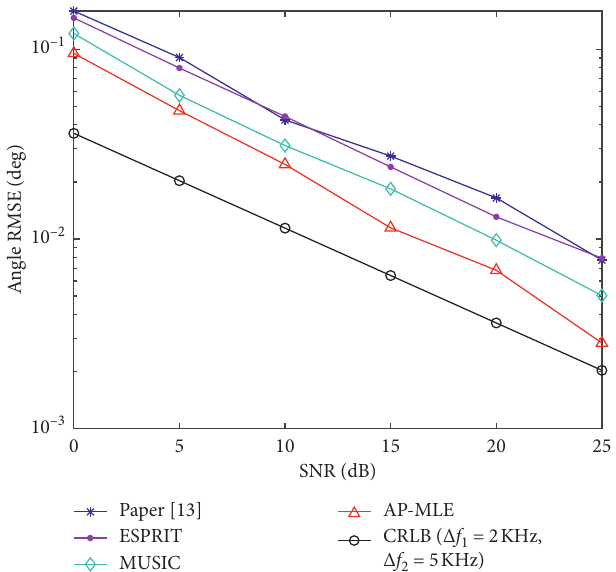
Figure 7: Angle CRLB and RMSE curves versus SNR.